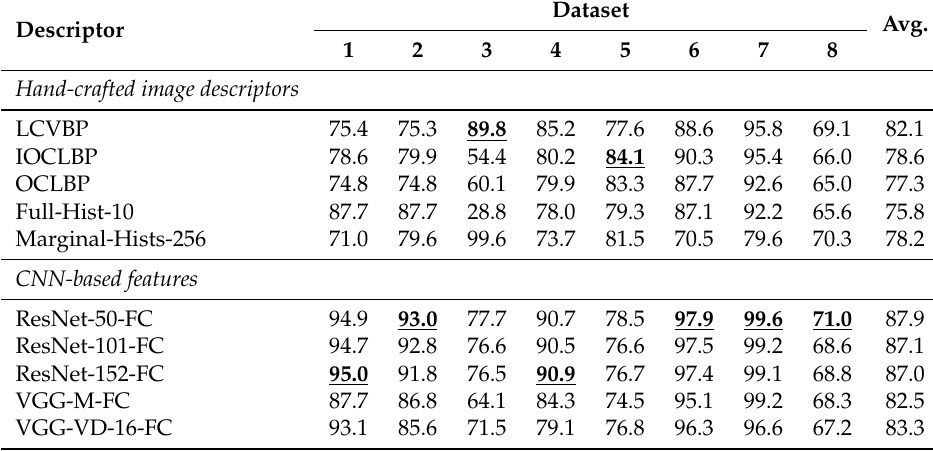
Table 8. Results of Experiment #2: non-stationary textures acquired under steady imaging conditions. Figures report overall accuracy by dataset. Boldface denotes the highest value; underline signals a statistically-significant difference between the best hand-crafted and the best CNN-based descriptor. Descriptors are listed in ascending order of by-experiment rank (best first).